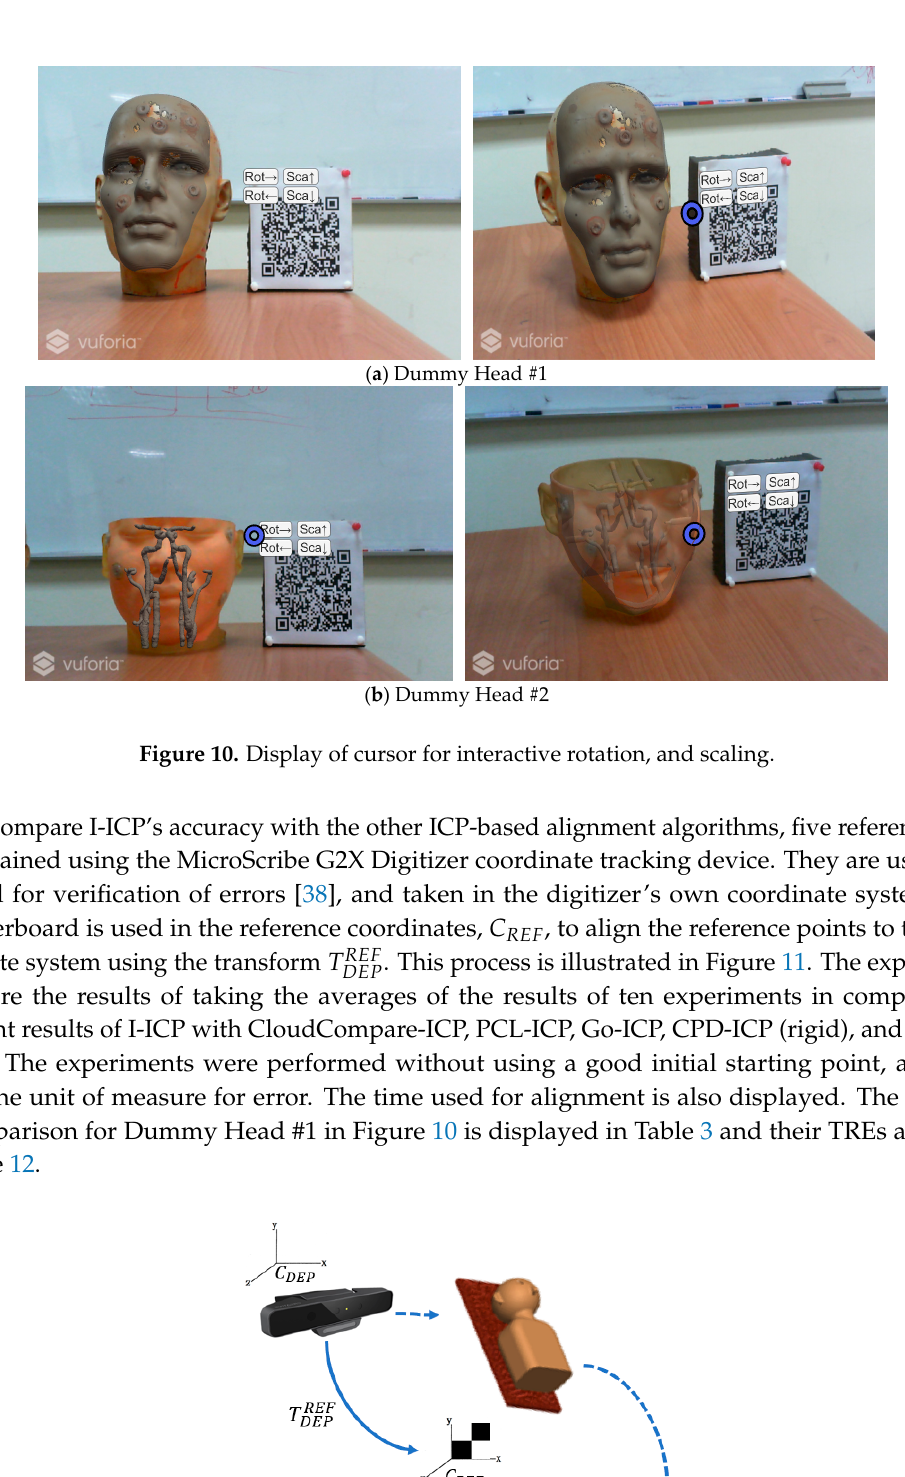
Figure 9. The Result of Marker Detection and Overlaying the Medical Images over the Dummy Head.